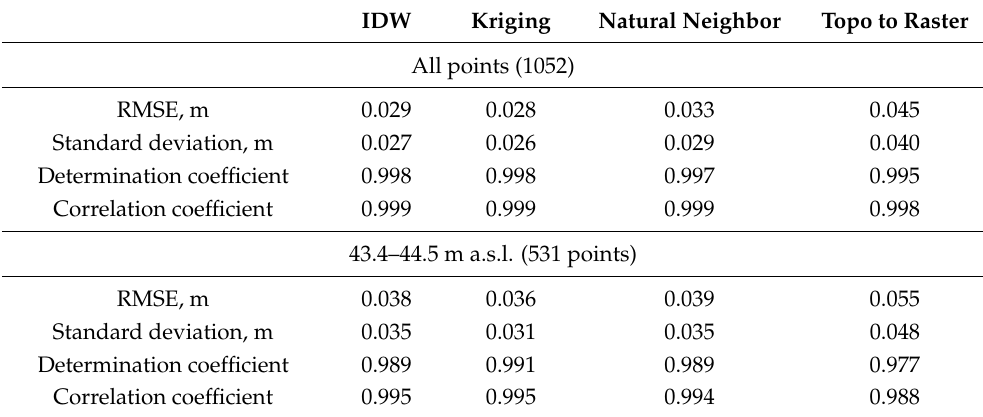
Table 2. Results of the statistical analysis of the generated digital elevation models.